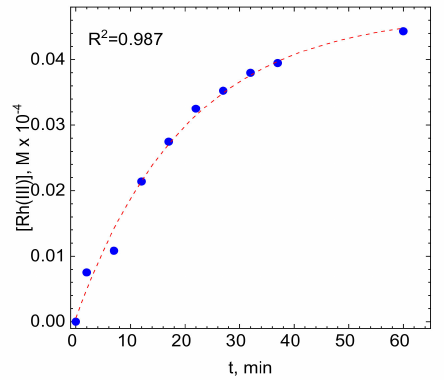
Figure 6. Kinetic curve obtained during the desorption test. Experimental conditions: V = 1200 rpm, [C] = 1 g, [Rh(III)] 0 = 0 M, pH = 1, [Br] − = 0.1 M T = 50 ◦ C.